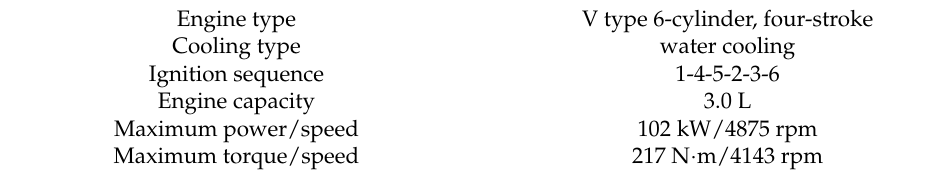
Table 2. Parameters of the engine.